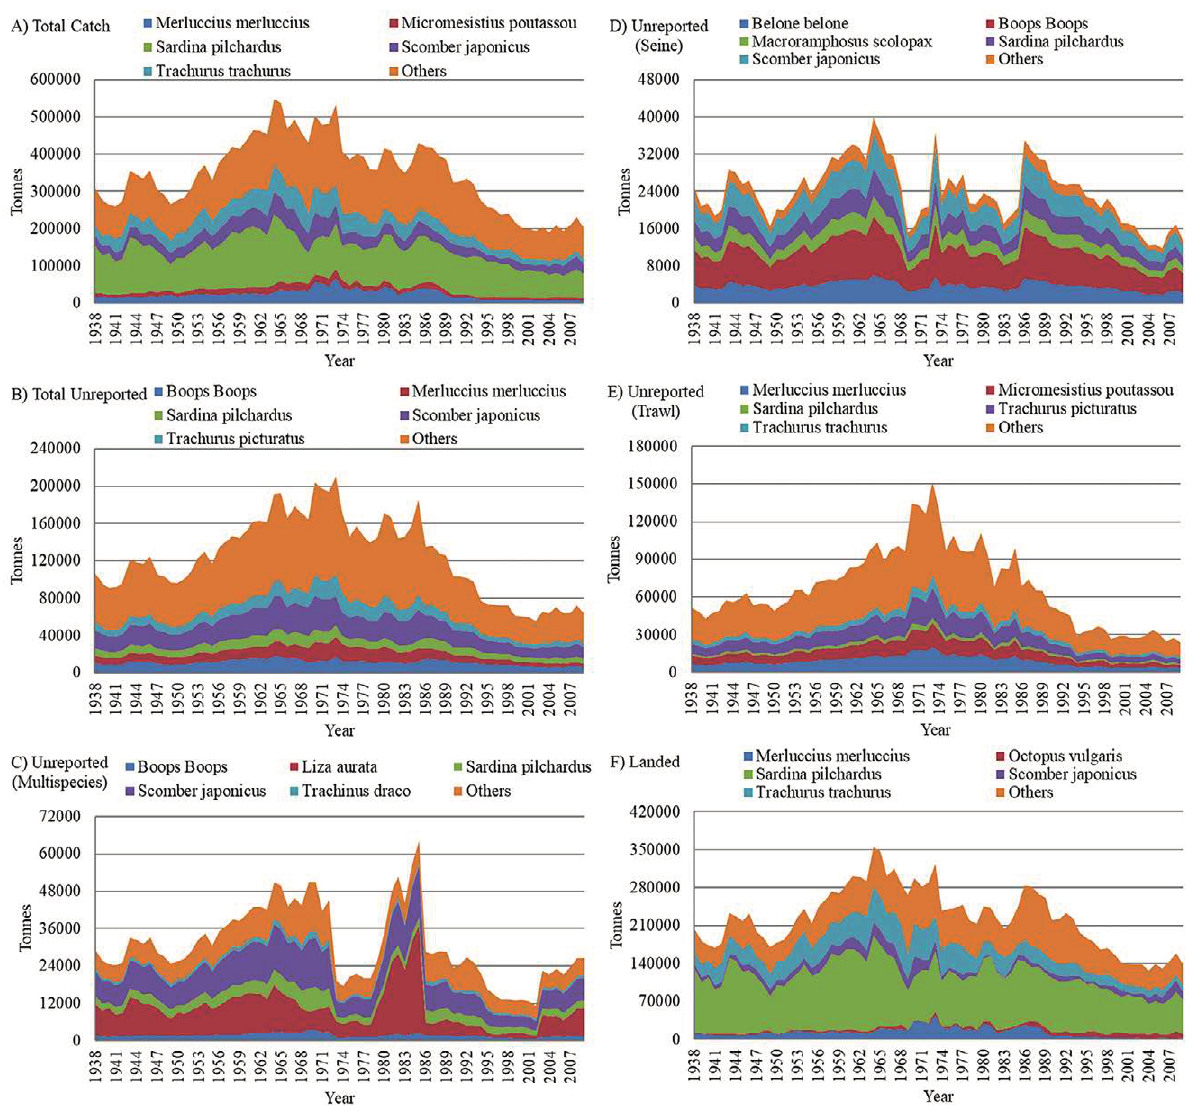
Fig. 2. – Catches of main species, unreported discards (including per métier) and landed catches. A, total catches; B, unreported; C, unreported multispecies; D, unreported purse seine; E, unreported trawl; F, landed catches. Source: Portuguese National Statistical Office – INE. Table 4. – Number of taxa present in landings and unreported (discarded)